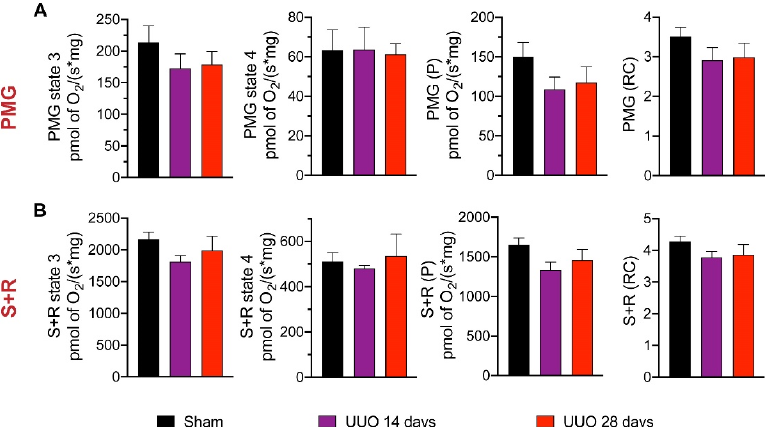
Figure 4. Mitochondrial respiration parameters in cardiac tissue of rats with unilateral ureteral ob- struction (UUO) for 14 and 28 days. Respiratory parameter-related data for ( A ) CI-linked respiration and ( B ) CII-linked respiration: state 3 (S3), oligomycin-induced state 4 (S4), oxidative phosphoryla- tion (OxPhos)-associated respiration (P), and respiratory control (RC). Data represent mean ± SEM of 5–6 independent experiments. PMG: pyruvate-malate-glutamate; S+R: succinate plus rotenone; CI: Complex I; CII: Complex II.